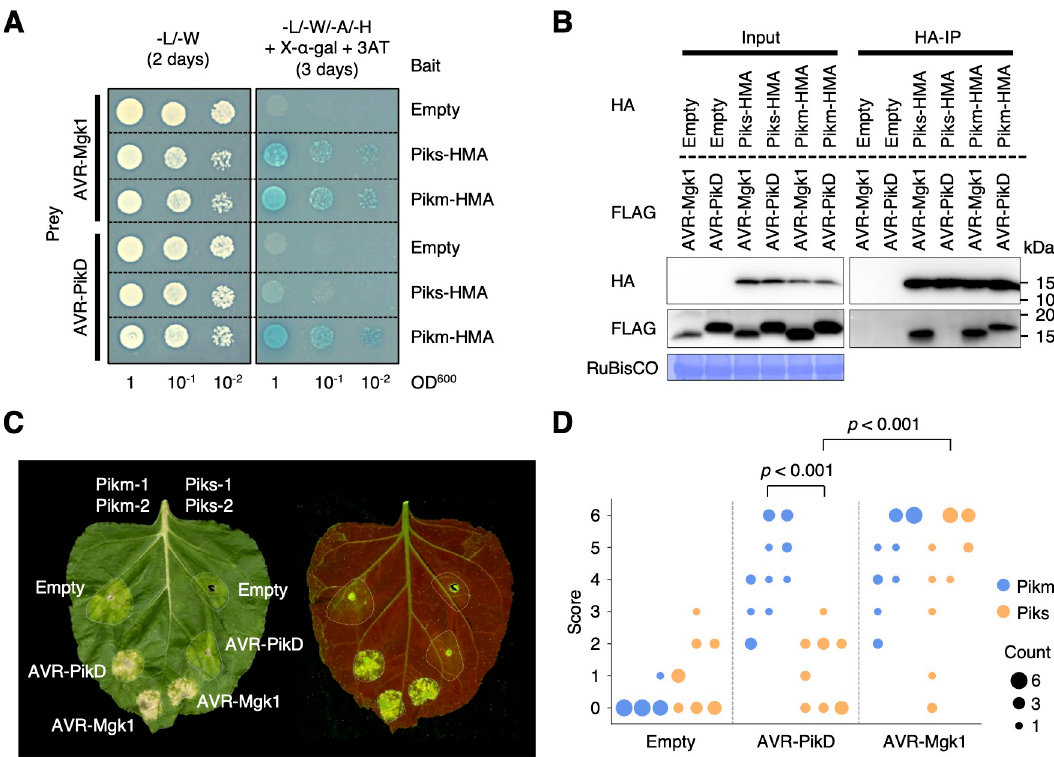
Fig 7. Piks specifically responds to AVR-Mgk1 but not to AVR-PikD. (A) Yeast two-hybrid assays between the Pik integrated HMA domains and AVRs. We used Myc-tagged HMA domains and HA-tagged AVRs as bait and prey, respectively. Empty vector was used as a negative control. Left side: basal medium lacking leucine (L) and tryptophan (W) for growth control. Right side: basal medium lacking leucine (L), tryptophan (W), adenine (A), and histidine (H) and containing X- α -gal and 10 mM 3AT for selection. (B) In vitro co-IP experiments between the Pik integrated HMA domains and AVRs. We used N-terminally tagged HA:HMA and FLAG:AVR in the experiments, and the protein complexes were pulled down by HA:HMA using Anti-HA affinity gel. Empty vector was used as a negative control. The large subunit of ribulose bisphosphate carboxylase (RuBisCO) stained by Coomassie brilliant blue is shown as a loading control. (C) Representative images of HR cell death assay after transient co-expression of the AVRs with Pik-1 and Pik-2 in N . benthamiana . Pikm and Piks were tested on the left and right sides of the leaf, respectively. The empty vector only expressing p19 was used as a negative control. The leaves were photographed 5–6 days after infiltration under daylight (left) and UV light (right). (D) The HR in (C) was quantified. Statistically significant differences are indicated (Mann–Whitney U rank test). Each column represents an independent experiment. The data underlying Fig 7D can be found in S1 Data . AVR, avirulence; co-IP, co-immunoprecipitation; HMA, heavy metal-associated; HR, hypersensitive